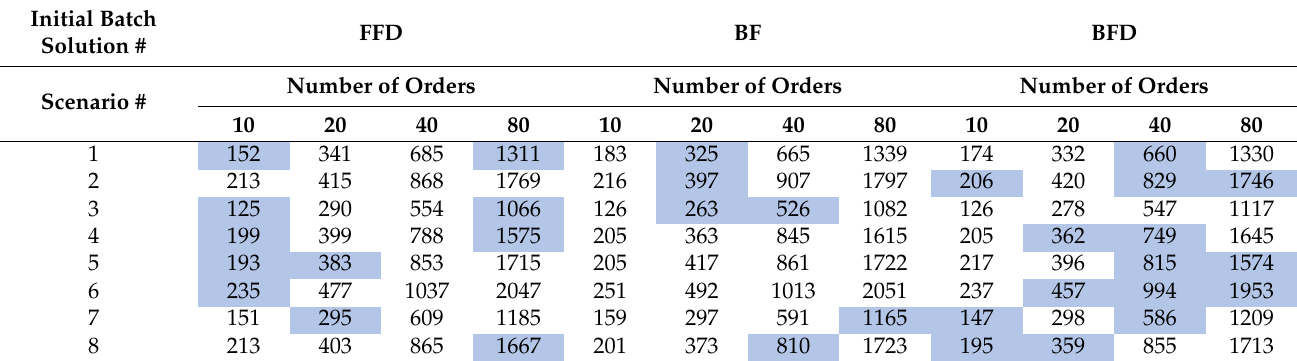
Table 3. Comparison of initial objective values obtained using FFD, BF, and BFD methods (unit: m).